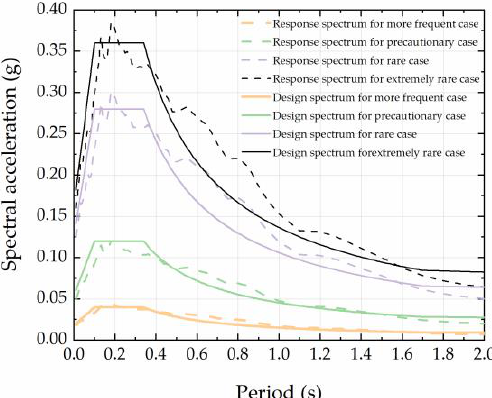
Figure 7. Average response spectrum and seismic design response spectrum for seismic precautionary intensity